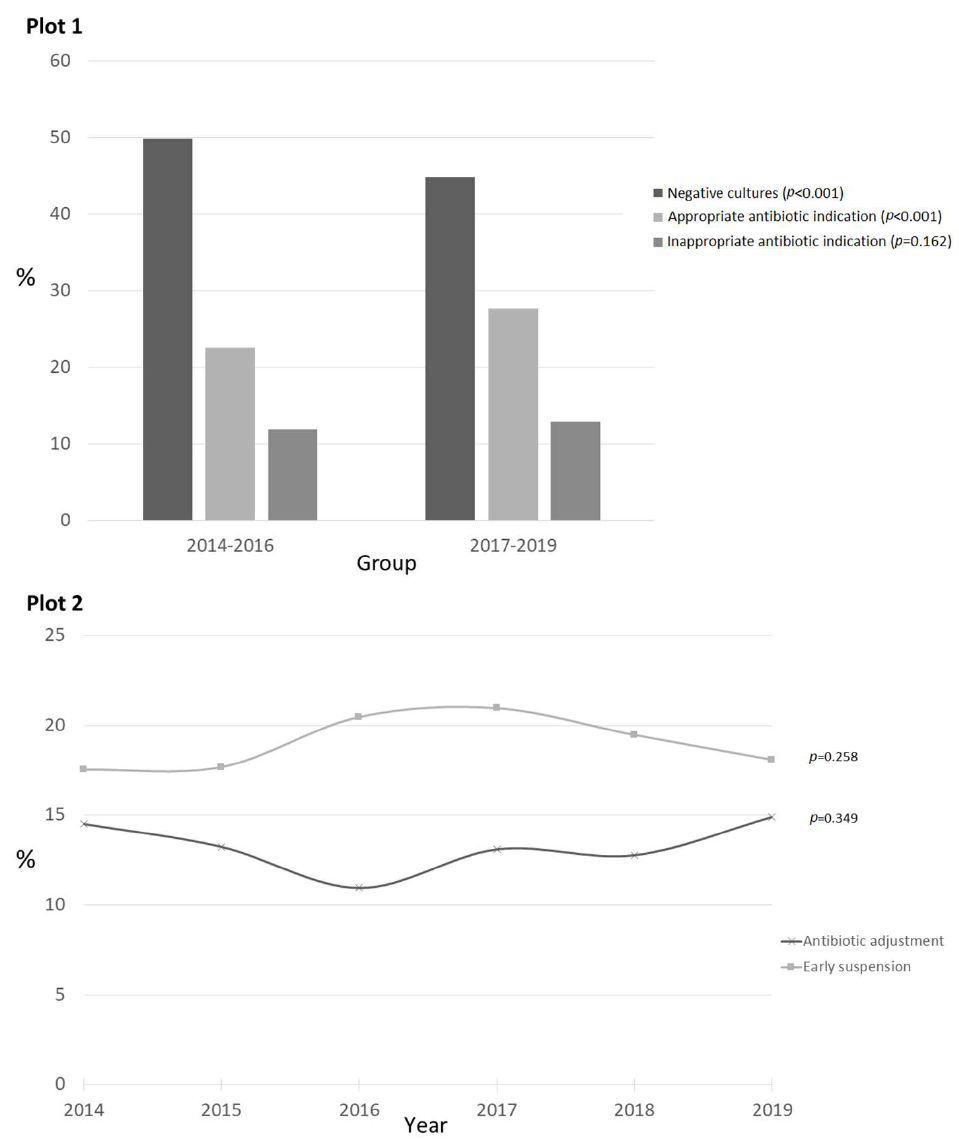
Figure 4. Regarding empirical antibiotic prescriptions, Plot 1 compares the accuracy of the antibiotic indications between the two time periods (2014–2016 vs. 2017–2019). It includes the proportion of appropriate antibiotic indications, inappropriate indications, and cases with negative cultures. Plot 2 represents the evolution over time of the need for antibiotics to be adjusted and suspended early in empirical